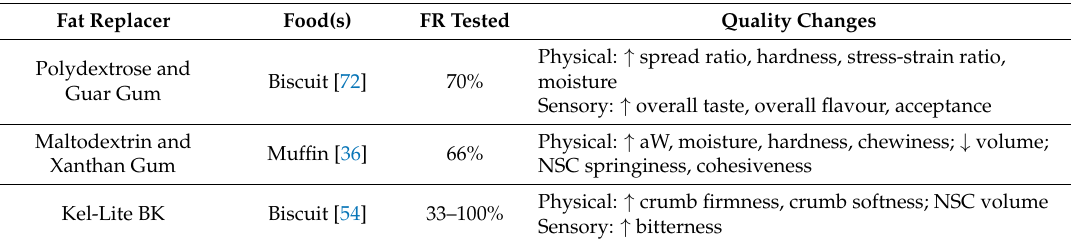
Table 4. Summary of quality changes of combined fat replacers in baked food